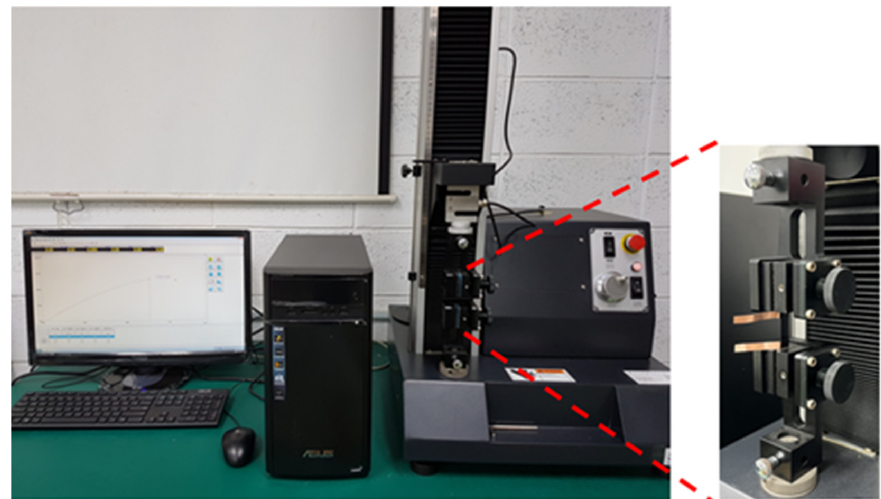
Figure 4. Experimental setup for the strain sensitivity test.